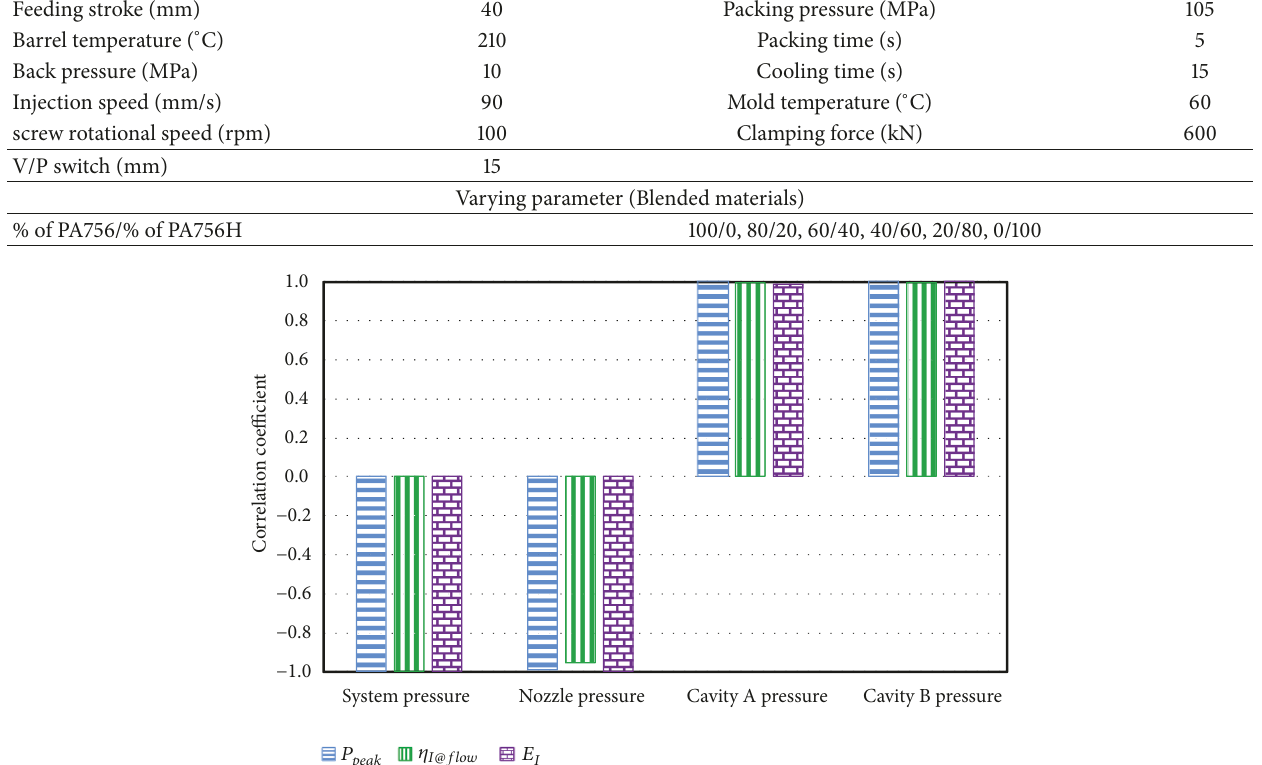
Figure 12: Correlation between pressure-based quality indexes and product weight for various barrel